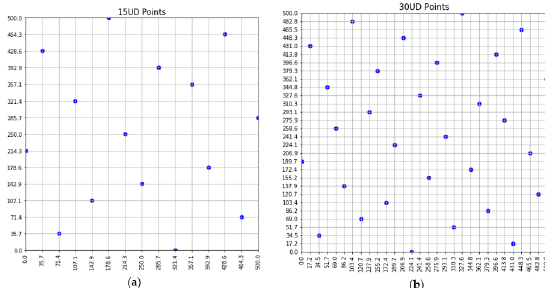
Figure 3. Uniform design showing the positions of synthetic sensors with: ( a ) n = 15; ( b ) n = 30